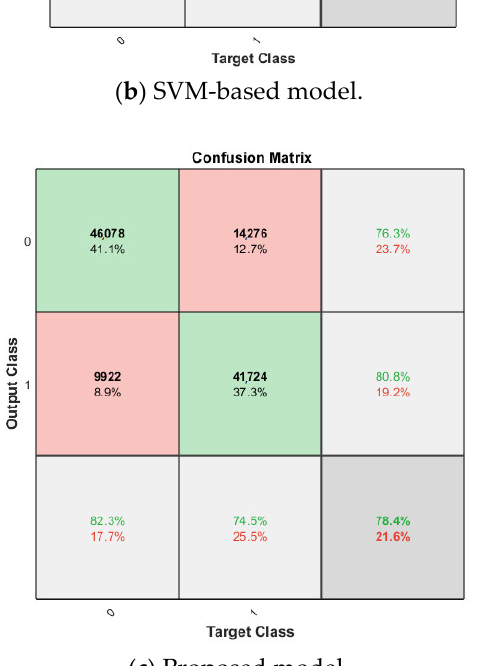
Figure 8. Confusion matrix on breast cancer dataset.